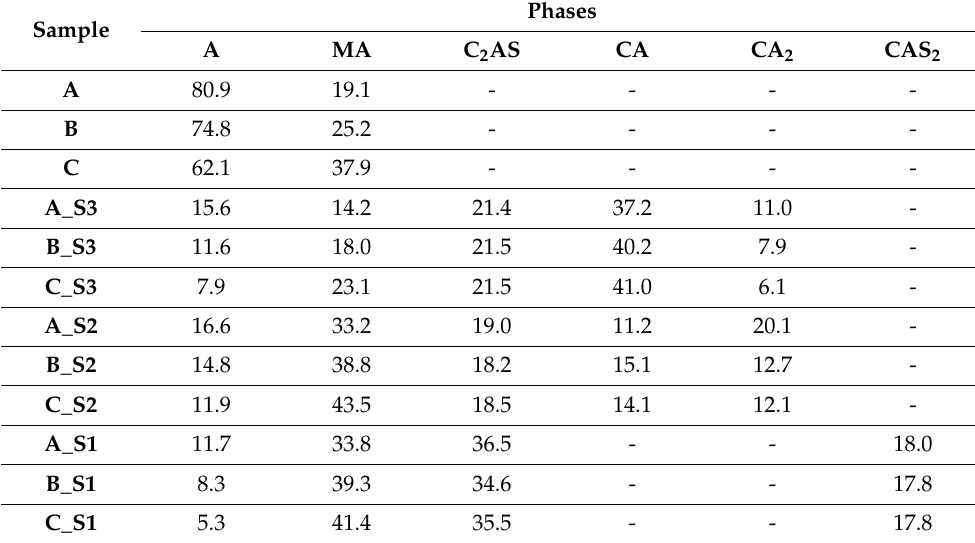
Table 4. Rietveld analysis of corroded mixtures 50 wt.% castable: 50 wt.%